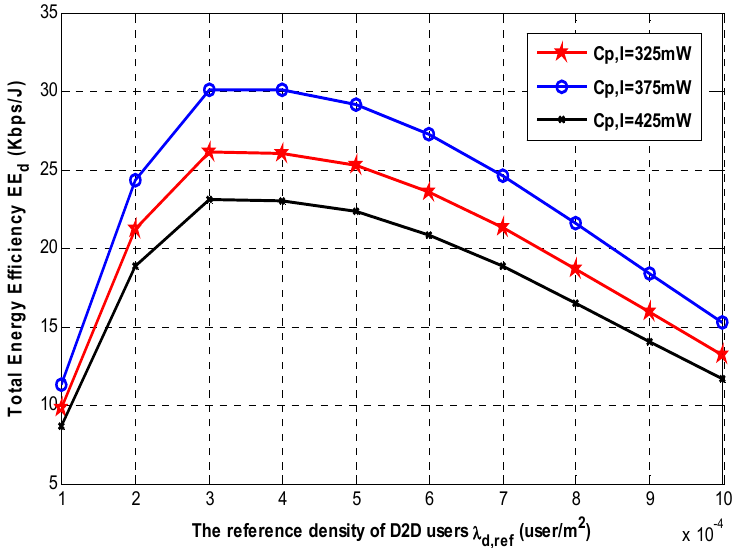
Figure 8. The energy efficiency of D2D users versus the reference density of D2D users by using the modified derivative algorithm with different parameters.